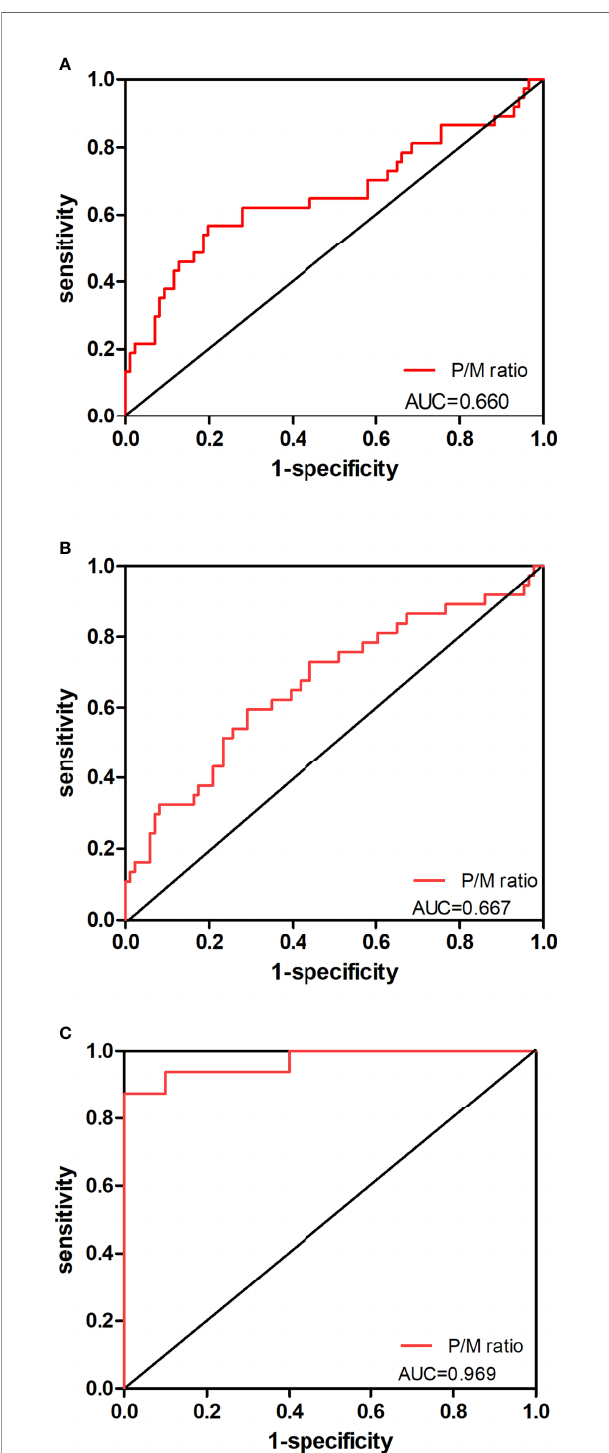
FIGURE 3 | Predictive value of P/M ratio in the risk classi fi cation of prostate cancer. The ROC curves for P/M ratio in (A) PCa patients at low-risk level versus those at intermediate-risk level, (B) PCa patients at intermediate-risk level versus those at high-risk level, and (C) PCa patients at low-risk level versus those at high-risk level are